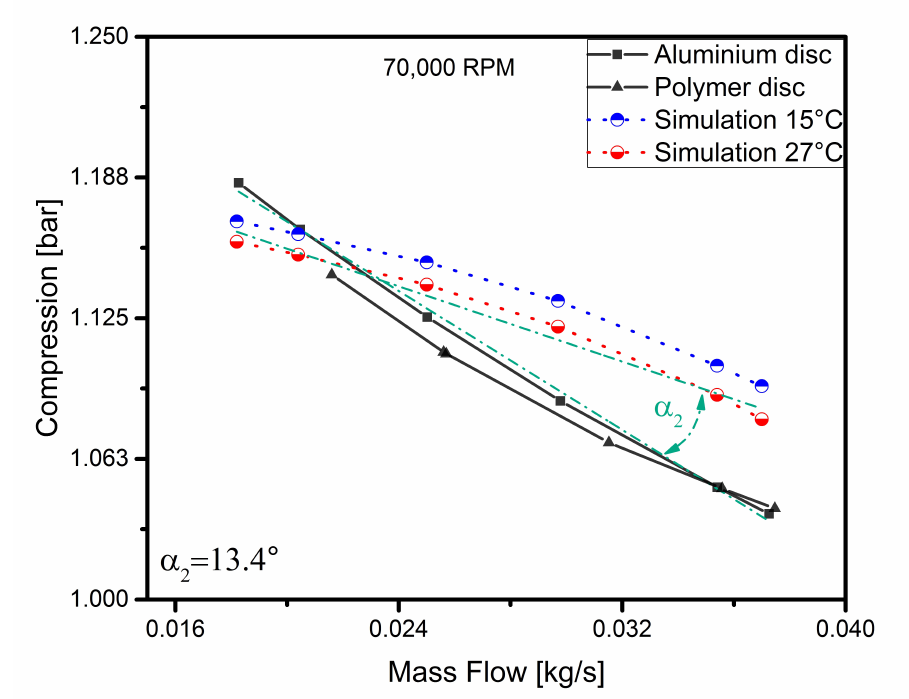
Figure 6. Simulation vs. experimental results for a speed of 70,000 rpm.